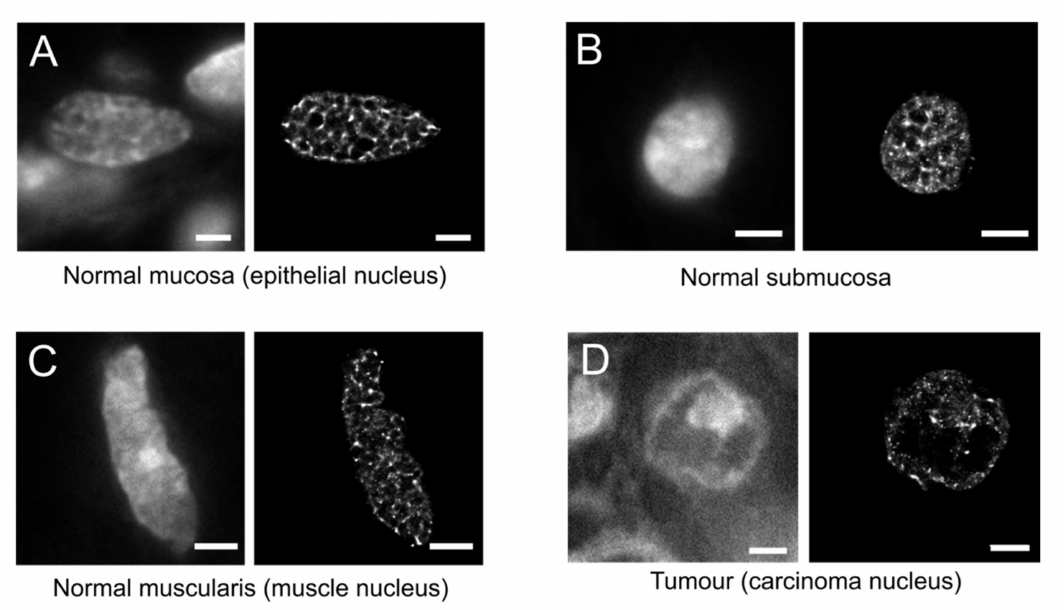
Figure 3. Representative SMLM images of normal colorectal cell nuclei (normal epithelial cell of normal mucosa, submucosa- derived stromal cell, smooth muscle cell within muscular layer) within normal colorectal tissue specimen ( A – C ), and of a carcinoma cell nucleus ( D ). Widefield images ( left ) and SMLM reconstructions ( right ) of nuclei imaged from human colorectal tissue sections. Scale bars: 3 µ m.